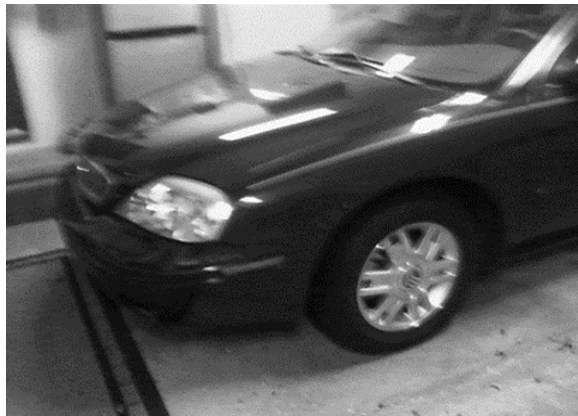
Figure 4. Participant 5 ’s car parked in the